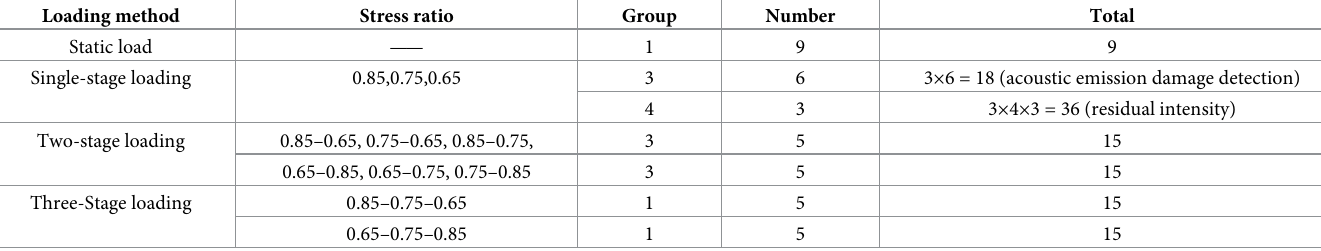
strength of the specimens was tested, with 3 beam specimens in each group. Table 5. Fatigue test scheme of concrete beam. Loading method Stress ratio Group Number Total Static load —— Single-stage loading Two-stage loading Three-Stage